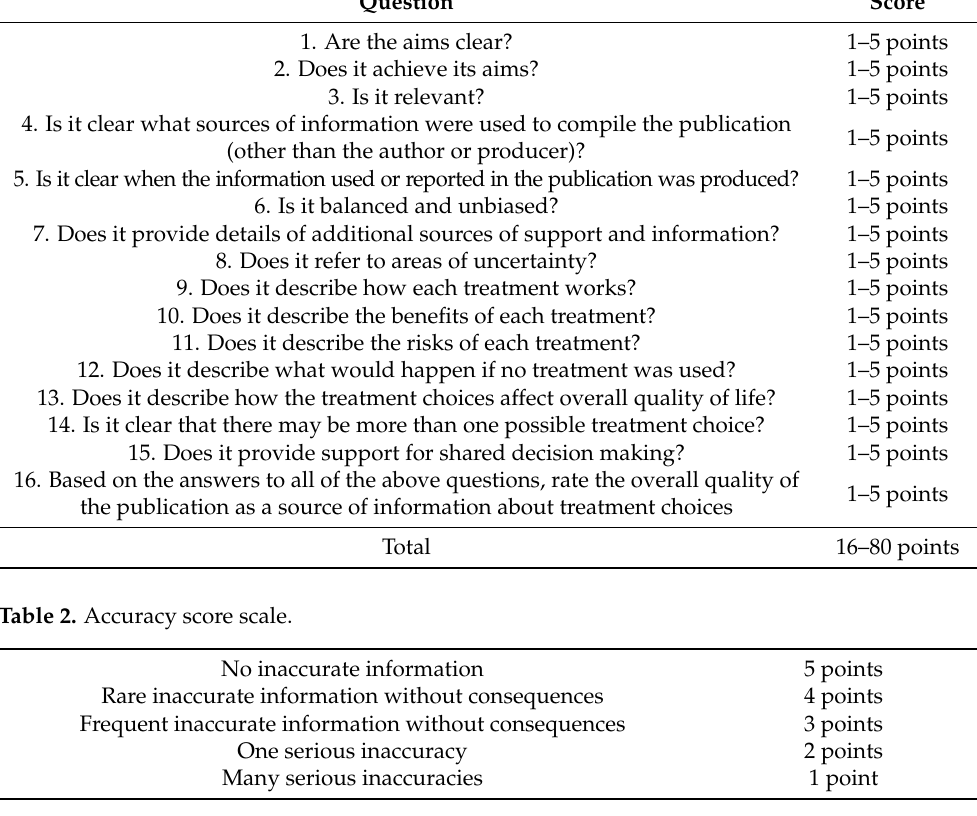
Table 1. DISCERN questionnaire for the evaluation of consumer health information.